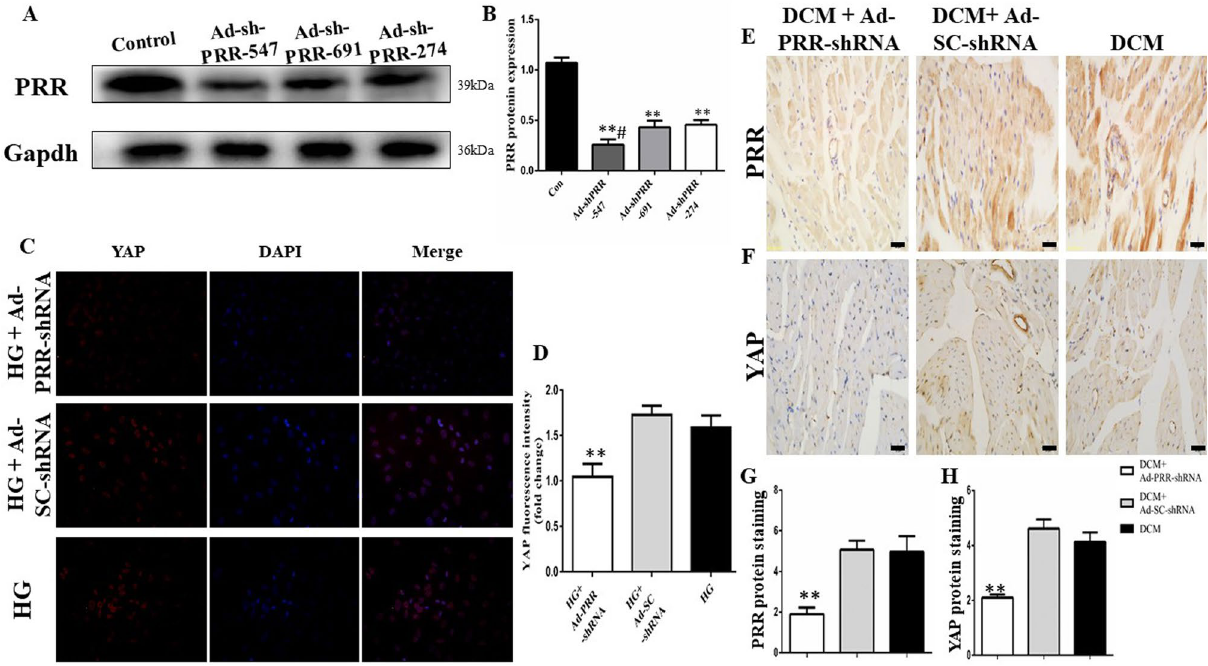
Figure 5. PRR and YAP protein expression, fibrosis and ROS production after PRR RNAi silencing. ( A ): Representative PRR protein expression after three types of Ad-PRR-shRNA transfection. Figure ( A ) is cropped picture, omitting the repeated blots from the same group. The full-length blots/gel is complemented in supplementary figure 5. ( B ) Quantitative analysis of the results shown in ( A ). ( C ) Immunofluorescence showing YAP protein expression in the cardiac fibroblasts (CFs) in the high glucose group, Ad-SC-shRNA group, and Ad-PRR-shRNA group. ( D ) Quantitative analysis of the results shown in ( C ). ( E – H ) PRR and YAP protein expression after PRR RNAi silencing. ( E ) PRR protein expression after PRR RNAi silencing in the 3 groups. ( G ) Quantitative analysis of the results shown in (E), ** p < 0.01 compared with the Ad-SC-shRNA group and DCM group. ( F ) YAP protein expression after PRR RNAi silencing in the 3 groups. ( H ) Quantitative analysis of the results shown in ( F ), ** p < 0.01 compared with the Ad-SC-shRNA group and DCM group. In this part, each group had n = 20 rats at beginning, in 2 weeks took 8 rats from each group for analysis. In 4 weeks after removing dead rats, the other of rats incorporate into analysis, in DCM group had 12 rats, Ad-SC-shRNA group had 12 rats and Ad-PRR-shRNA group had 11 rats